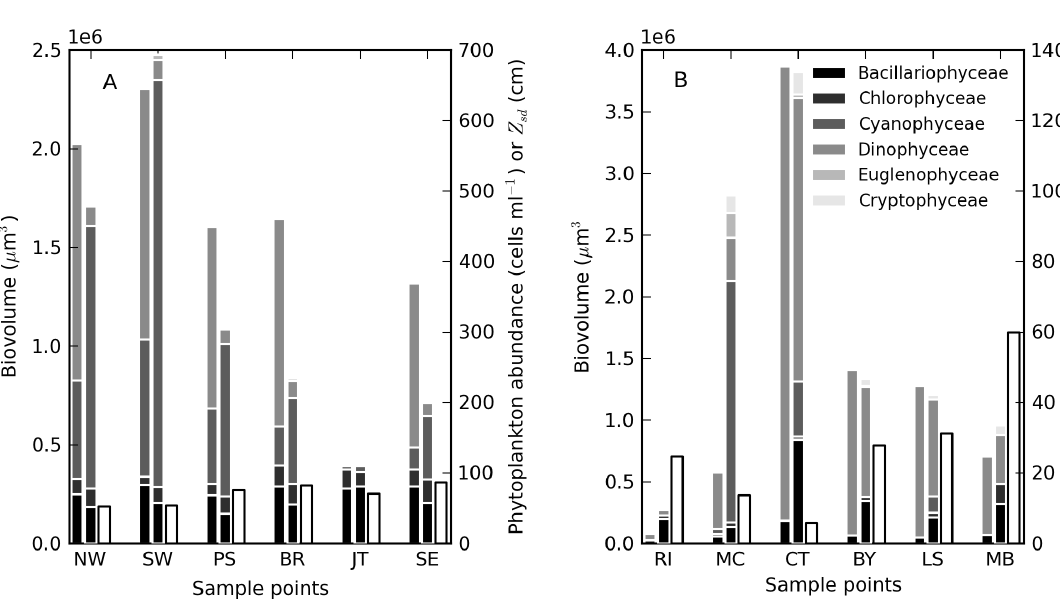
Figure 3. Mean biovolume (left-most bar) and abundance (center bar) of phytoplankton by group, and z (right-most bar) for sample points in ( A ) Theewaterskloof and ( B ) Loskop. sd The legend is the same in A and B. Cyanophyceae count for Loskop point MC has been scaled by a factor of 0.1. z is also scaled by a factor of 0.1 in sd